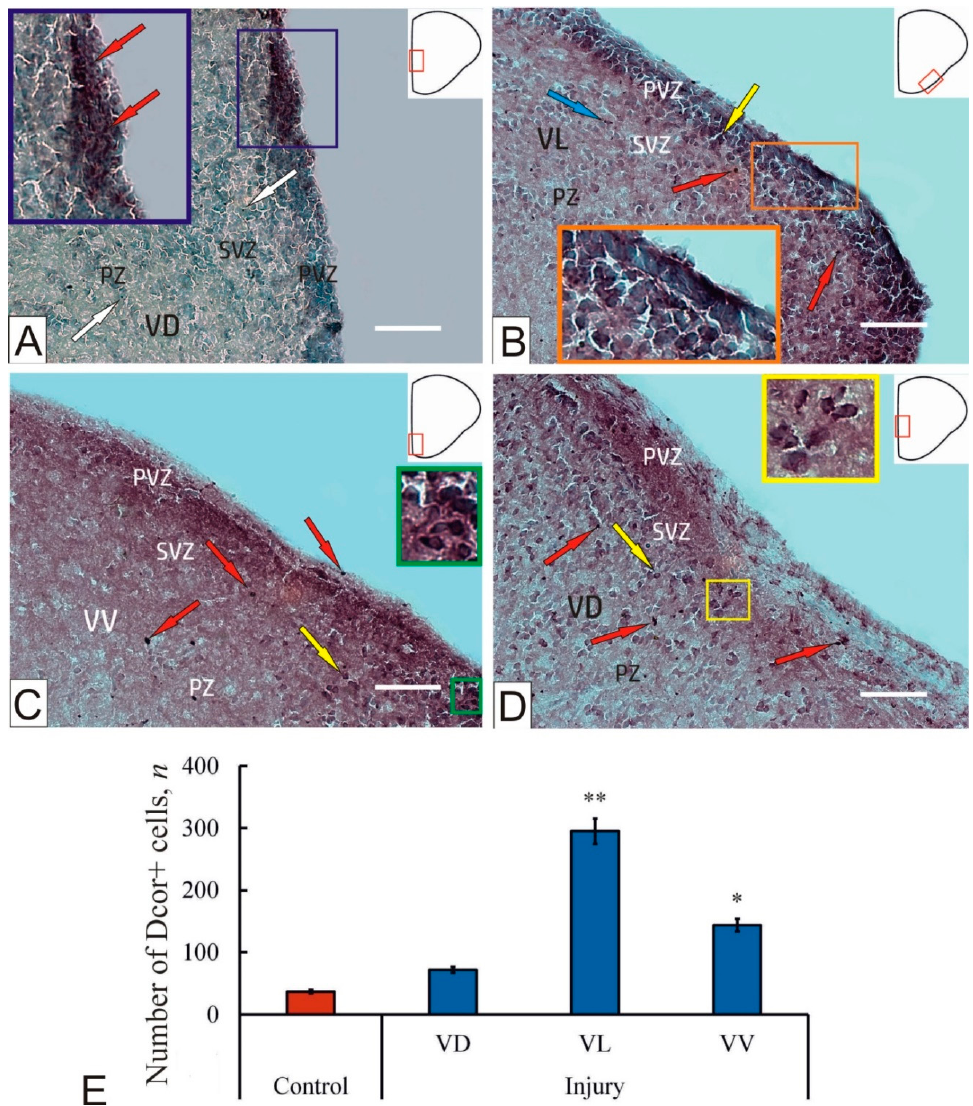
Figure 1. A representative image of doublecortin (DC) immunolabeling in the subpallial region of the intact telencephalon ( A ) of a juvenile Oncorhynchus masou and at 1 week after a traumatic injury ( B – D ) to the telencephalon: ( A ) localization of DC in intact subpallium, immunopositive cells (inset, red arrows), and granules (white arrows) in the parenchymal zone (PZ); ( B ) DC+ cells (inset) in lateral subpallial zone (VL), intensely DC-labeled cells (red arrow) and moderately DC-labeled cell (yellow arrow) in PVZ at 1 week post-injury, and DC+ granules (blue arrow); ( C ) post-traumatic expression of DC immunopositivity in ventral subpallial zone (VL), intensely labeled DC+ cells (red arrows) in PVZ and SVZ (an enlarged fragment is shown in the inset), and alternating with moderately-labeled cells (yellow arrow) in PZ; ( D ) patterns of DC-immunopositivity after injury in dorsal subpallium VD, intensely labeled cells (red arrows), moderately labeled cells (yellow arrows), and clusters of moderately labeled cells (inset); ( E ) the quantitative ratio of DC+ cells in intact animals (control group) and at 1 week post-injury ( n = 5 in each group, * p ≤ 0.05; ** p ≤ 0.01; significant difference vs. control). Student–Newman–Keuls test. Immunohistochemical labeling of doublecortin in combination with methyl green staining. Scale bar: 100 µ